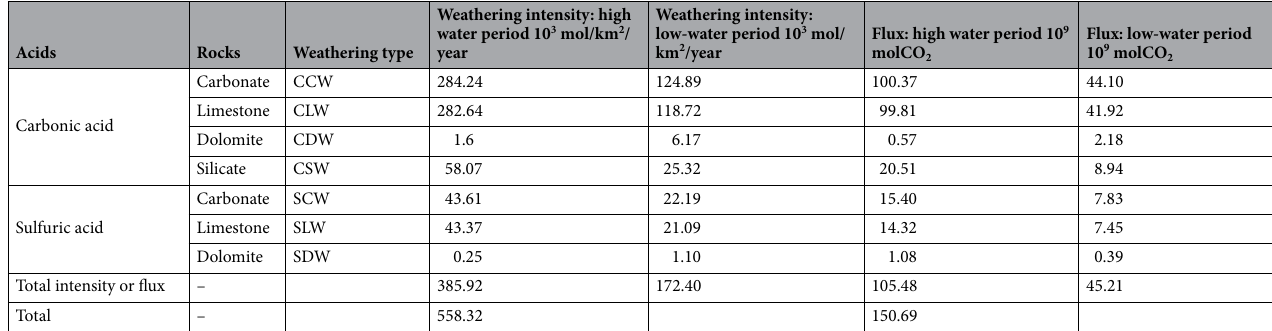
Table 10 lists the fluxes of each end-member in the study area. The total CO 2 flux consumed by petrochemical weathering was 150.69 × 10 9 mol/year, i.e., 100.37 and